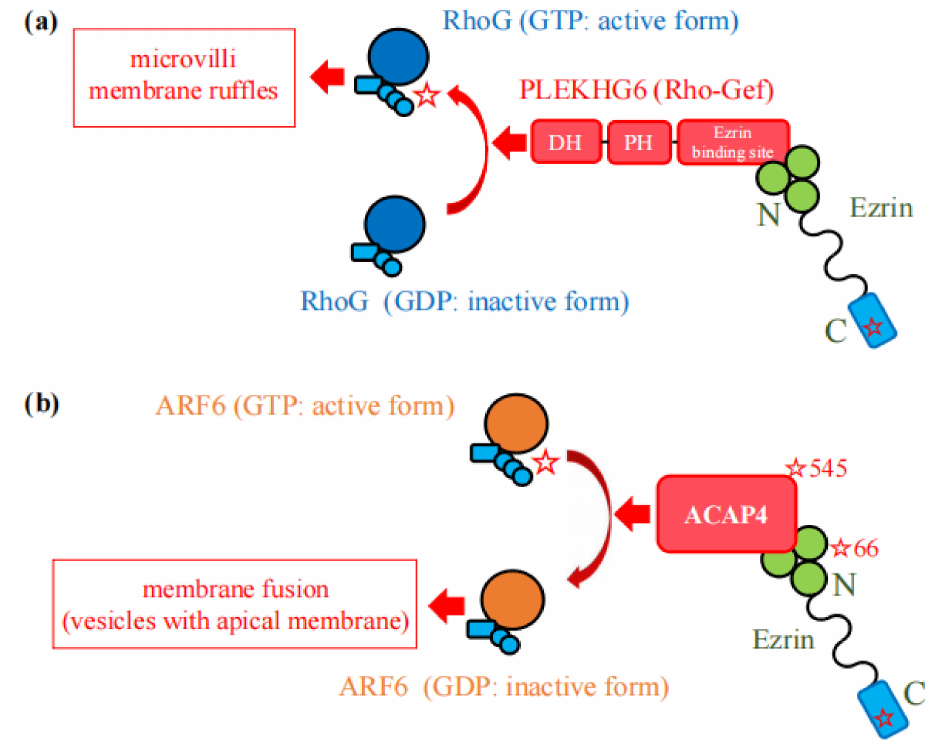
Figure 5. Ezrin activates Rho GTPases. ( a ) RhoG (shown by blue circles) is activated by ezrin/PLEKHG6 interactions. PLEKHG6 is shown by three tandem red boxes. DH and PH represent Dbl homology domain and plekstrin homology domain, respectively. The N-terminal FERM domain of ezrin (shown by a green clover) binds to the C-terminal region (ezrin binding site) of PLEKHG6. The Ezrin-PLEKHG6 complex activates its effector, RhoG, and finally induces the formation of mi- crovilli and membrane ruffles. ( b ) ARF6 (shown by an orange circle) is activated by ezrin/ACAP4 interactions. ACAP4 is shown by a red box. Ezrin is phosphorylated at Ser 66 and interacts with ACAP4 phosphorylated at Thr 545 . The Ezrin/ACAP4 complex and activated ARF6 together induce membrane fusion of intracellular tubulovesicles with the apical